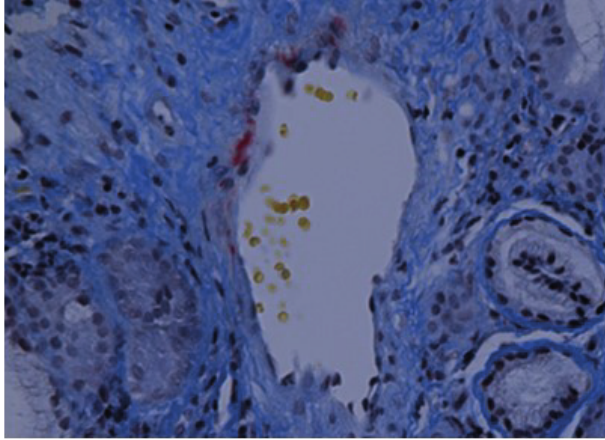
Figure 4. Showing fibrinoid necrosis and vein involvement.